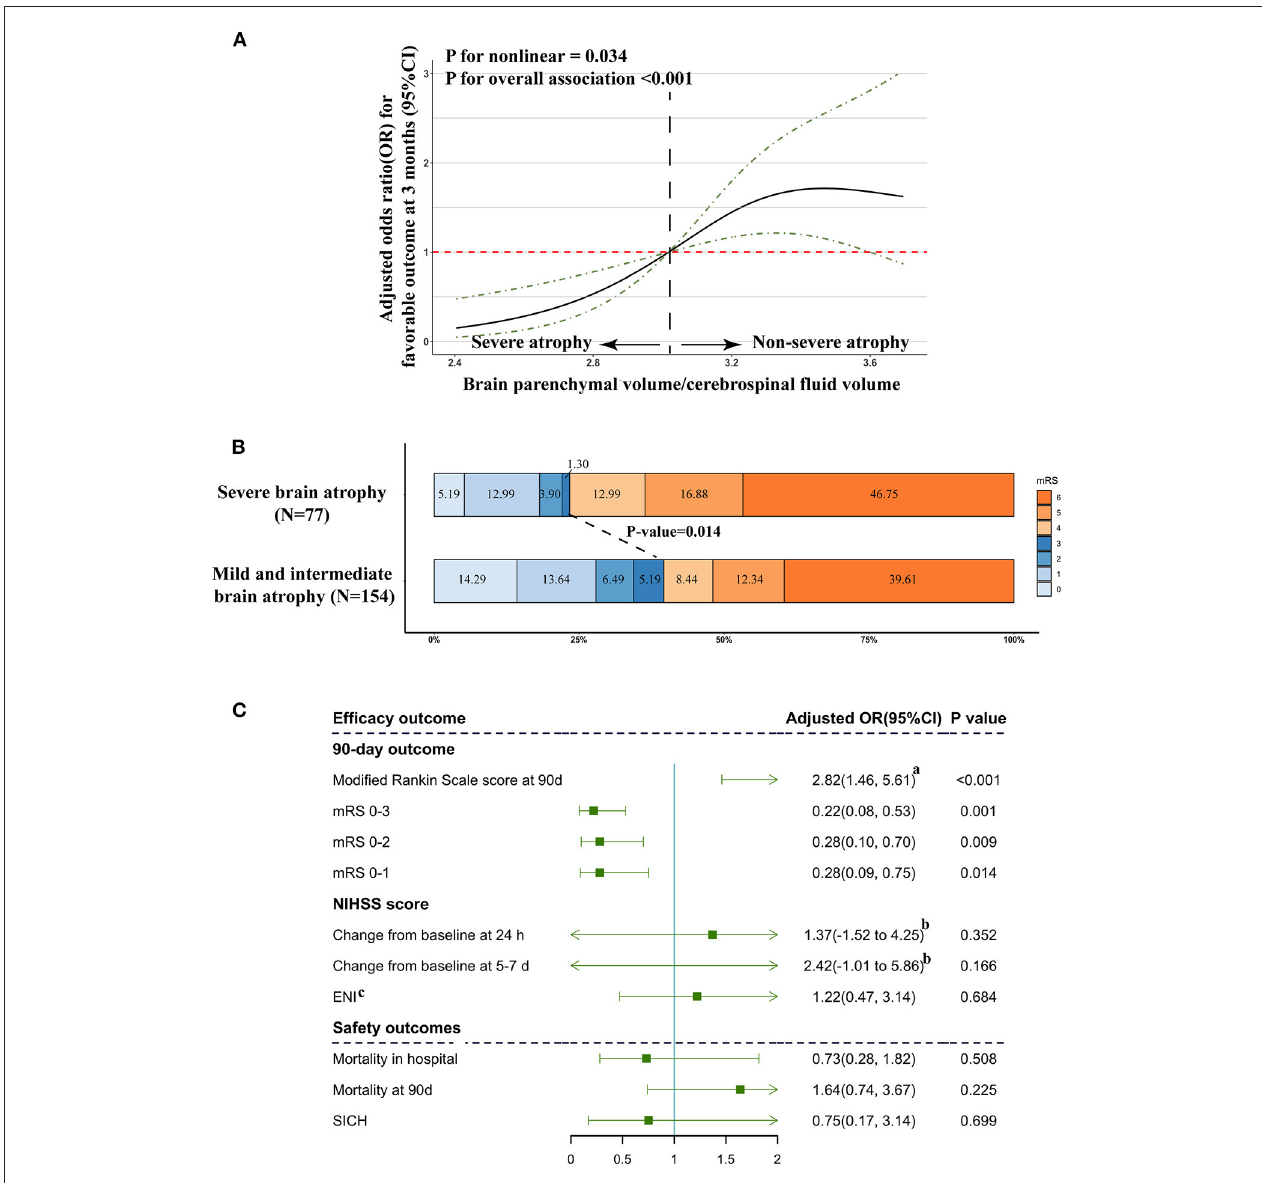
FIGURE 1 | Association of severe brain atrophy with clinical outcome. (A) Association of brain atrophy with favorable outcome (mRS ≤ 3) in a restricted cubic spline model. Brain atrophy was estimated by quantifying BPV/CFV. ORs, solid line; 95% CI, dashed lines. (B) Primary outcomes according to brain atrophy status. Distribution of modified Rankin Scale (mRS) scores at 3 months in patients treated with endovascular treatment. (C) Multivariable logistic regression analysis revealed the relationship between brain atrophy and efficacy outcome and safety outcome. Adjusted estimates of outcome were calculated using multiple regression, taking the following variables into account: age, sex, dyslipidemia, atrial fibrillation, baseline NIHSS score, baseline PC-ASPECTS, mTICI, PC-CS, and onset to recanalization time. (a) Common odds ratio; (b) β and 95% CI values were estimated from a multivariable linear regression model, which was adjusted by multiple regression, taking the following variables into account: age, sex, dyslipidemia, atrial fibrillation, baseline NIHSS score, baseline PC-ASPECTS, mTICI, PC-CS score, and onset to recanalization time. (c) ENI: early neurological improvement was estimated by a reduction of > 8 or return to 0 on NIHSS compared with baseline score at 24h after